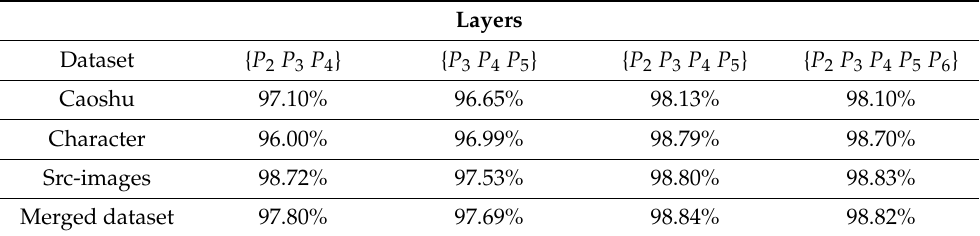
Figure 8. The result of SSD on KNU datasets. ( a ) The result on Caoshu dataset, clearly showing that there is a serious problem with detection emerged from inaccurate localization. ( b ) The result on Src-images with good detection. Table 3. Detection rate (DT) with different feature maps.